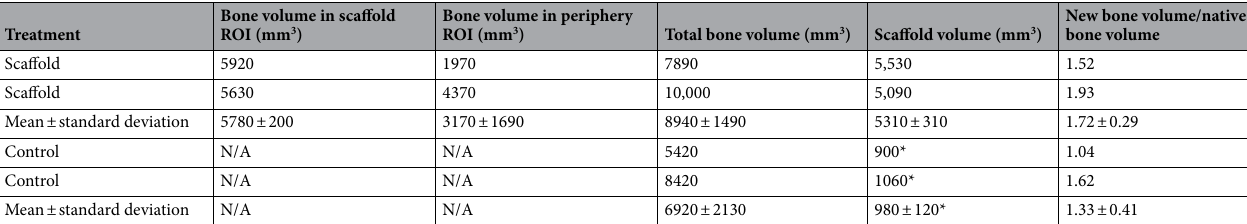
Table 2. Micro-CT outcome data for bone and scaffold volume. Results from individual specimens are presented, as well as means and standard deviations. The scaffold and peripheral ROIs were not applicable for the control group. *No scaffold was present in the control specimens. This scaffold volume represents an inherent error in using intensity thresholds to compute the volume.